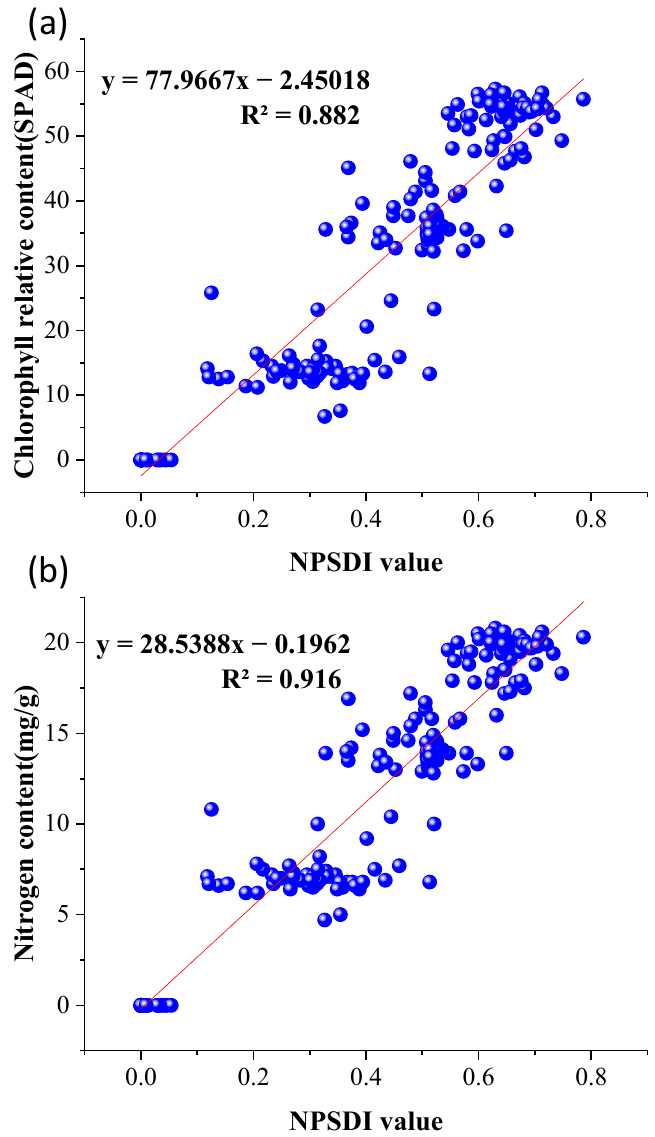
Figure 17. ( a ) Correlation between the NDVI and SPAD. ( b ) Correlation between the NDVI and NC.